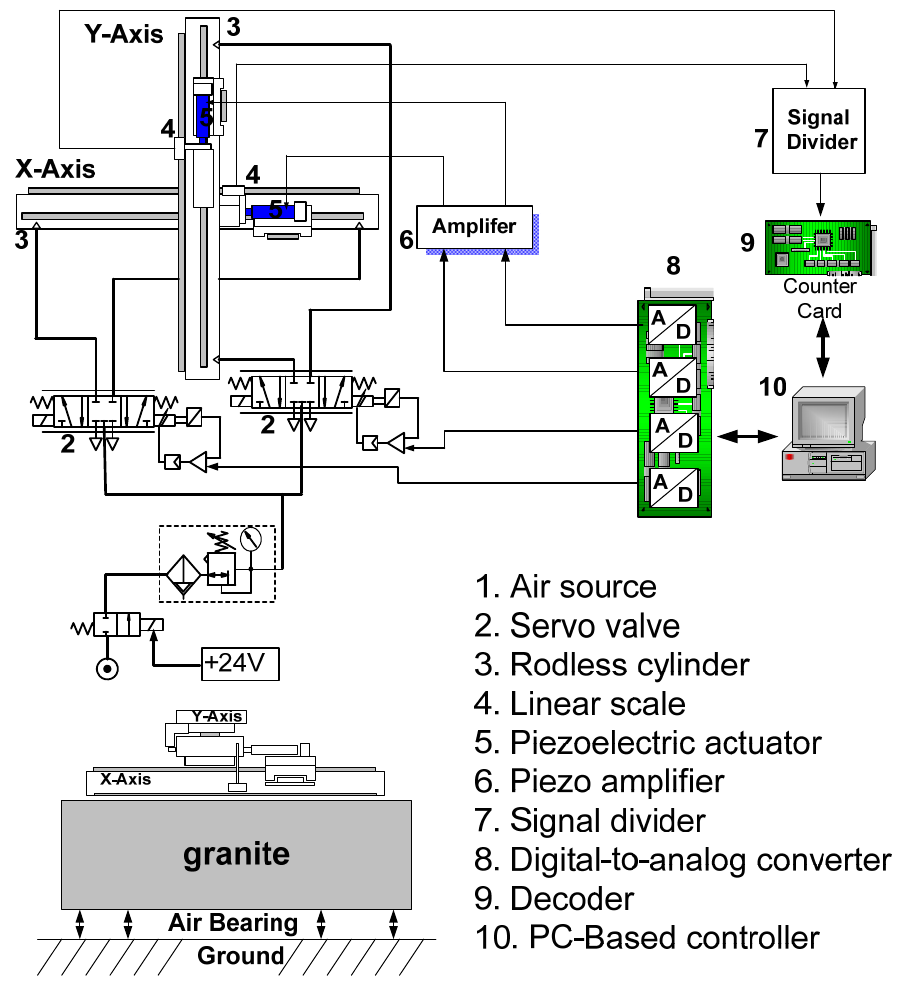
Figure 2. Layout of the X-Y dual-axial pneumatic-piezoelectric hybrid